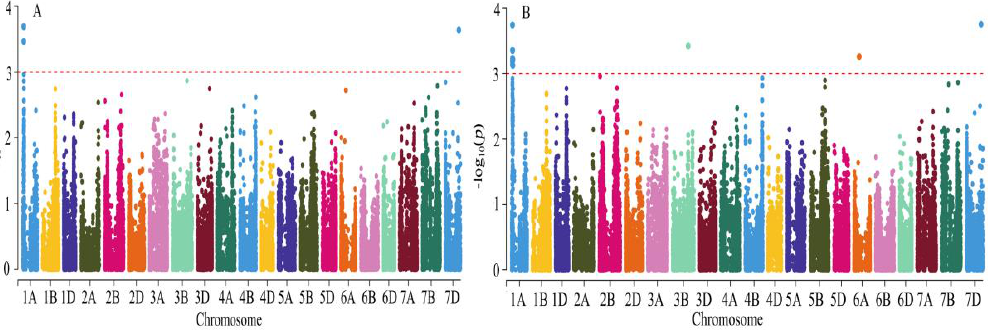
Figure 2. Linkage disequilibrium (LD) decay across the whole wheat genome, A, B, and D sub- genomes within the association panel consisted of 150 wheat varieties (lines) over a 300 Mb physical distance. The horizontal line indicates the critical value of r 2 .